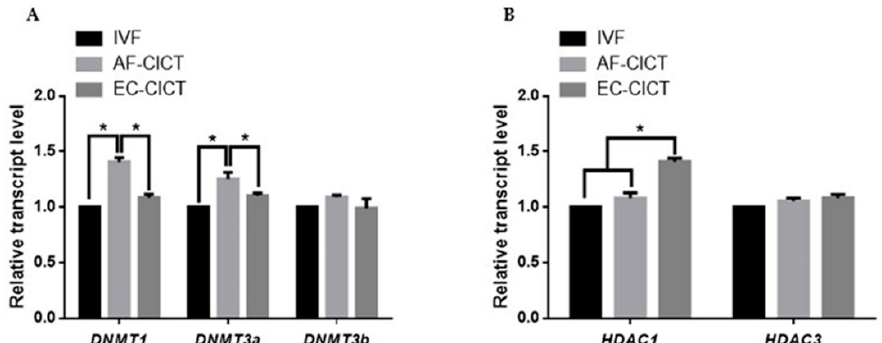
Figure 5. Relative mRNA expression levels of DNA methylation and histone acetylation in blastocysts determined by quantitative reverse transcription PCR. ( A ) Relative mRNA expression levels of DNMT1, DNMT3a, DNMT3b. ( B ) Relative mRNA expression of HDAC1 , and HDAC3 in blastocysts from the IVF, AF-CICT, and EC-CICT groups. The data are from three independent experiments and are means ± SEM (* p < 0.05).